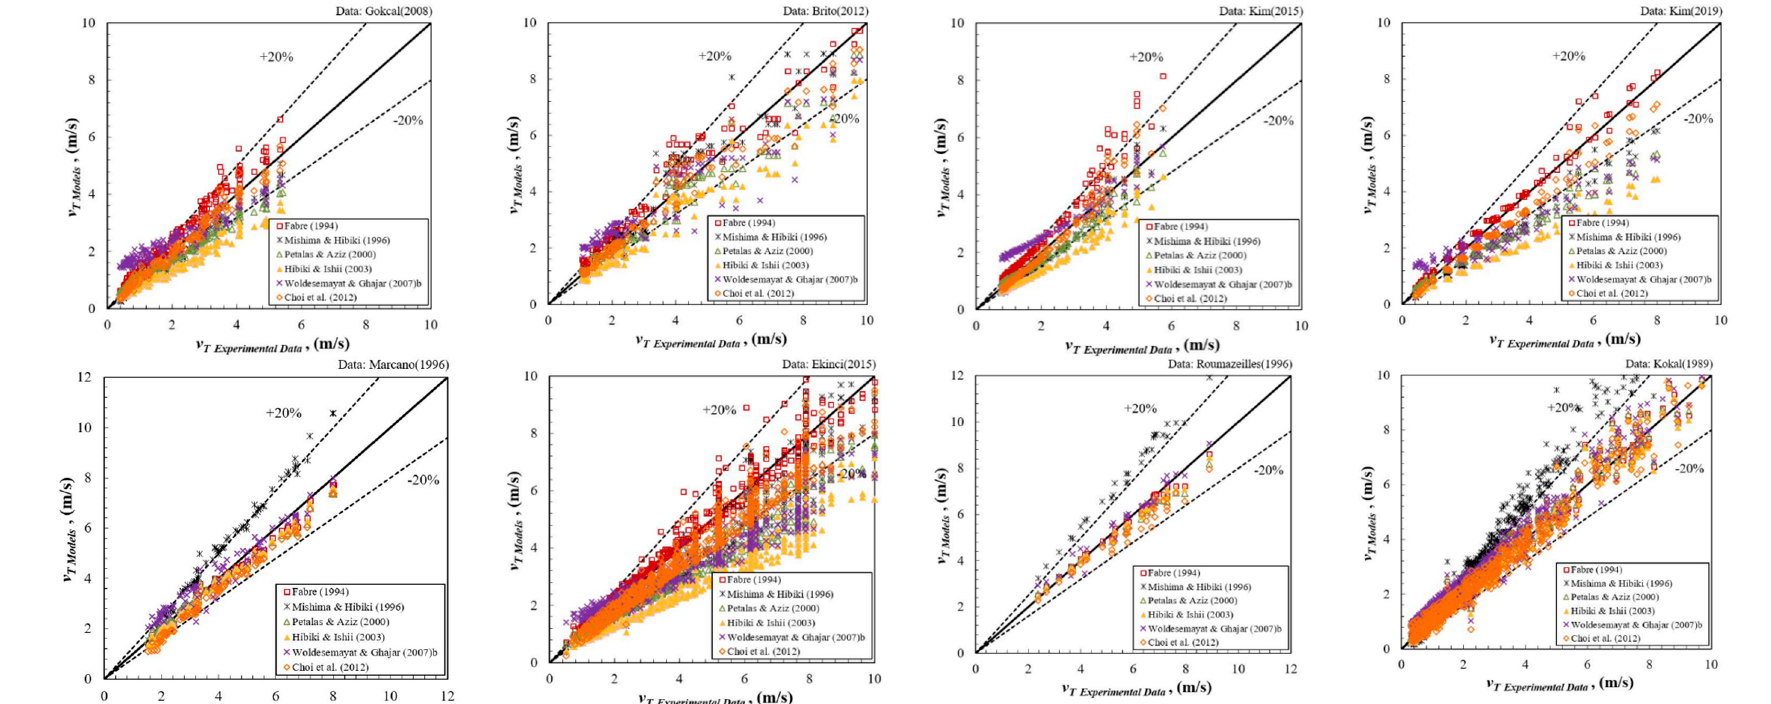
Figure 7. Translational velocity models comparison.